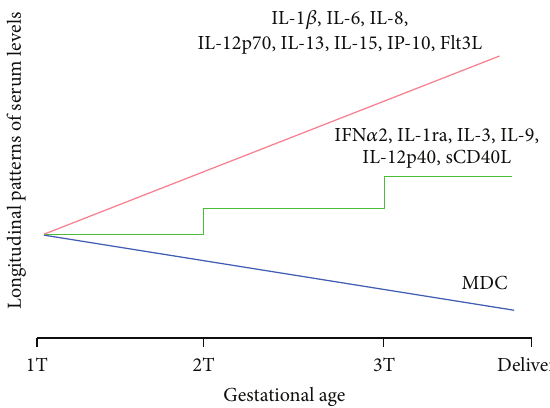
Figure 5: Cytokines with linear relationships to time-dependent